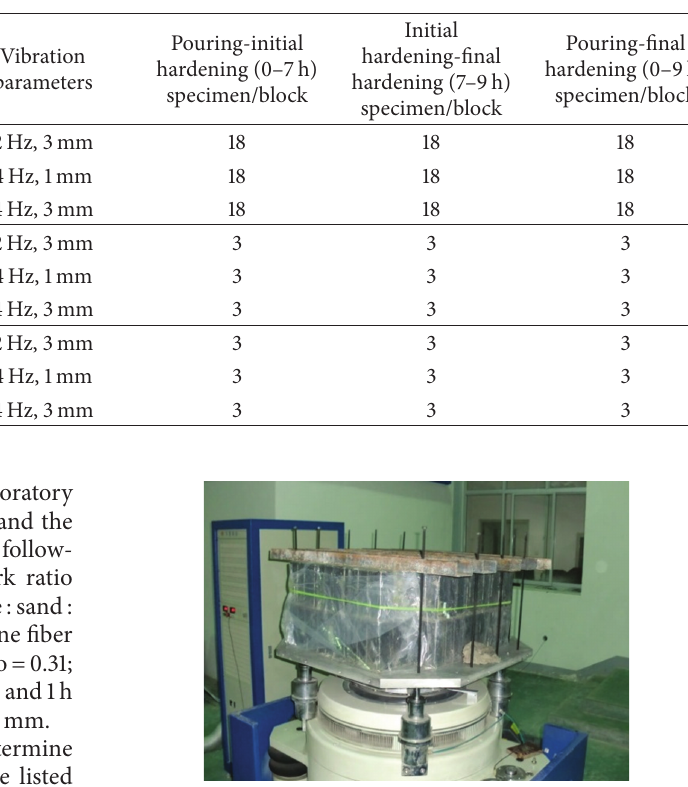
Figure 4: Specimen fixation